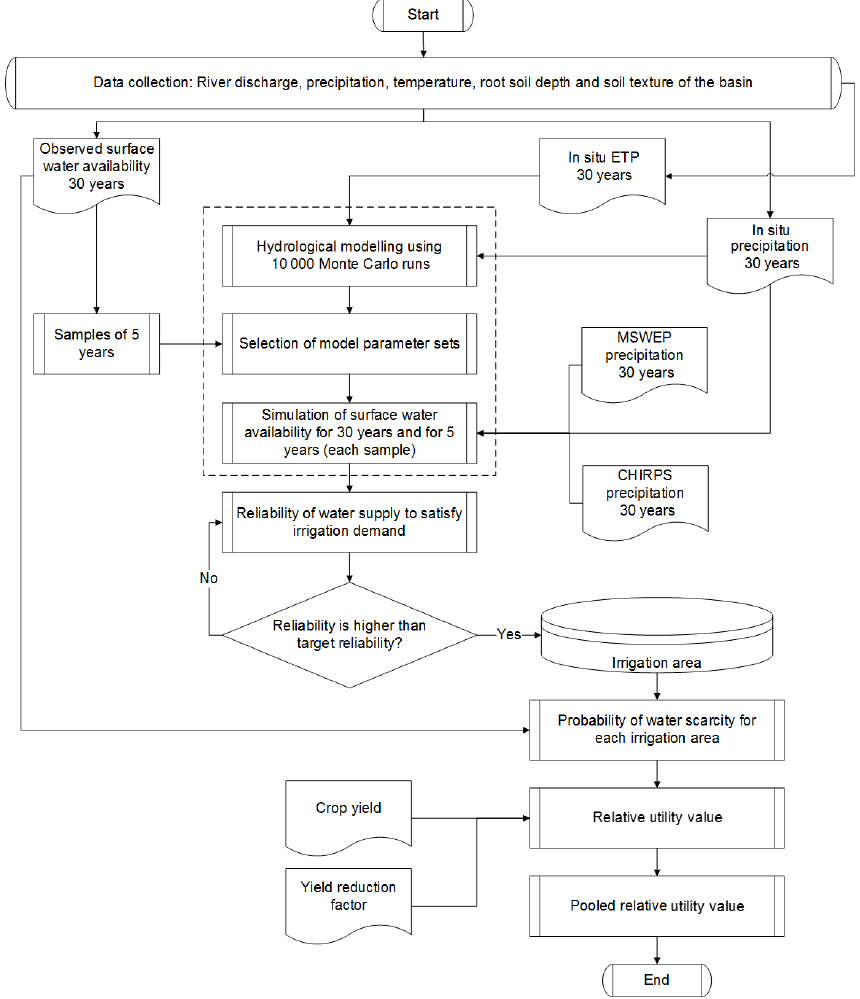
Figure 1. Workflow of the study to determine the pooled relative utility value using different irrigation areas obtained from in situ, CHIRPS and MSWEP precipitation